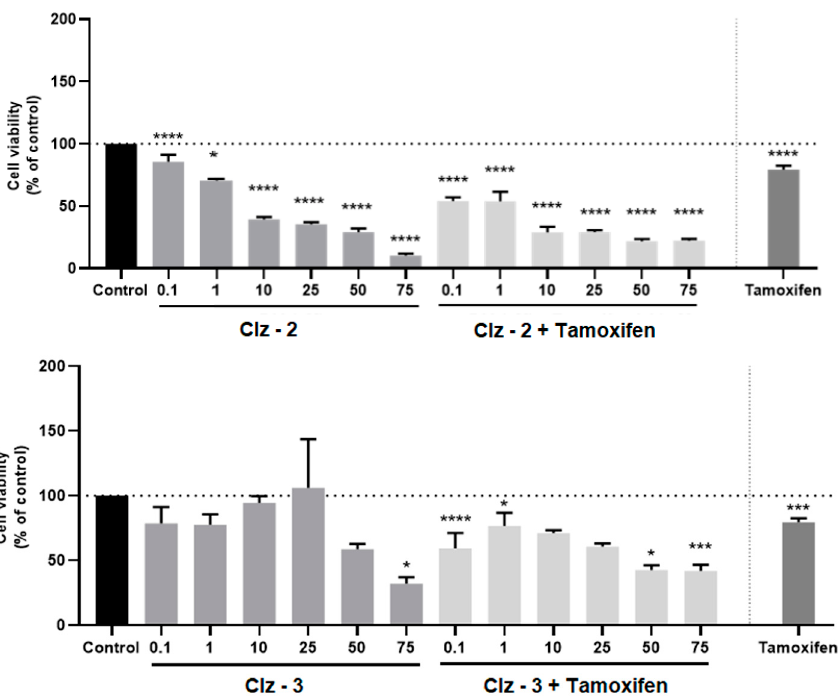
Figure 5. Relative viabilities of MCF-7 cells after 72-h incubations of various concentrations of either just Clz–1, Clz–2, and Clz–3, or each Coelenterazine derivative combined with Tamoxifen (2.21 μ M). * Significantly different from control (p <0.05).